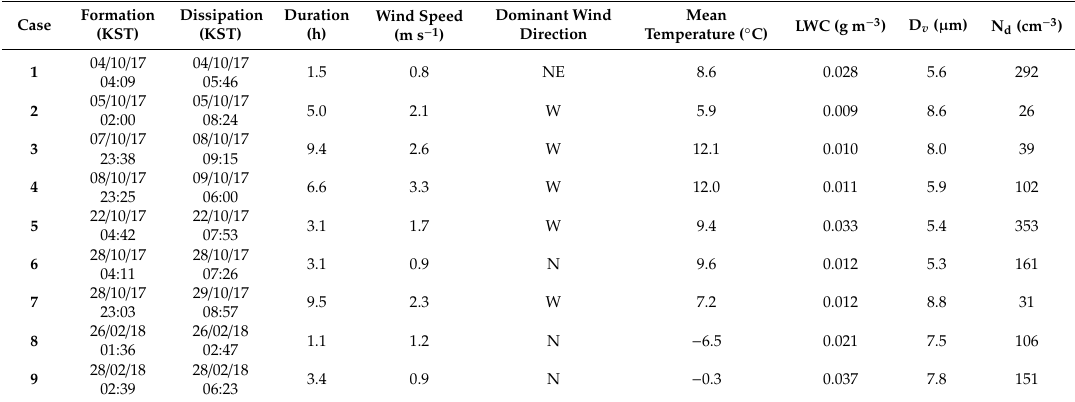
Table 2. Mean values of microphysics parameters for the 9 cases calculated from the 0.1 Hz FM-120 data-set at 2 m above ground and meteorological parameters gathered from the PWD-52 at 2.3 m above ground and WXT-520 sensor at 3 m above ground during the entire fog